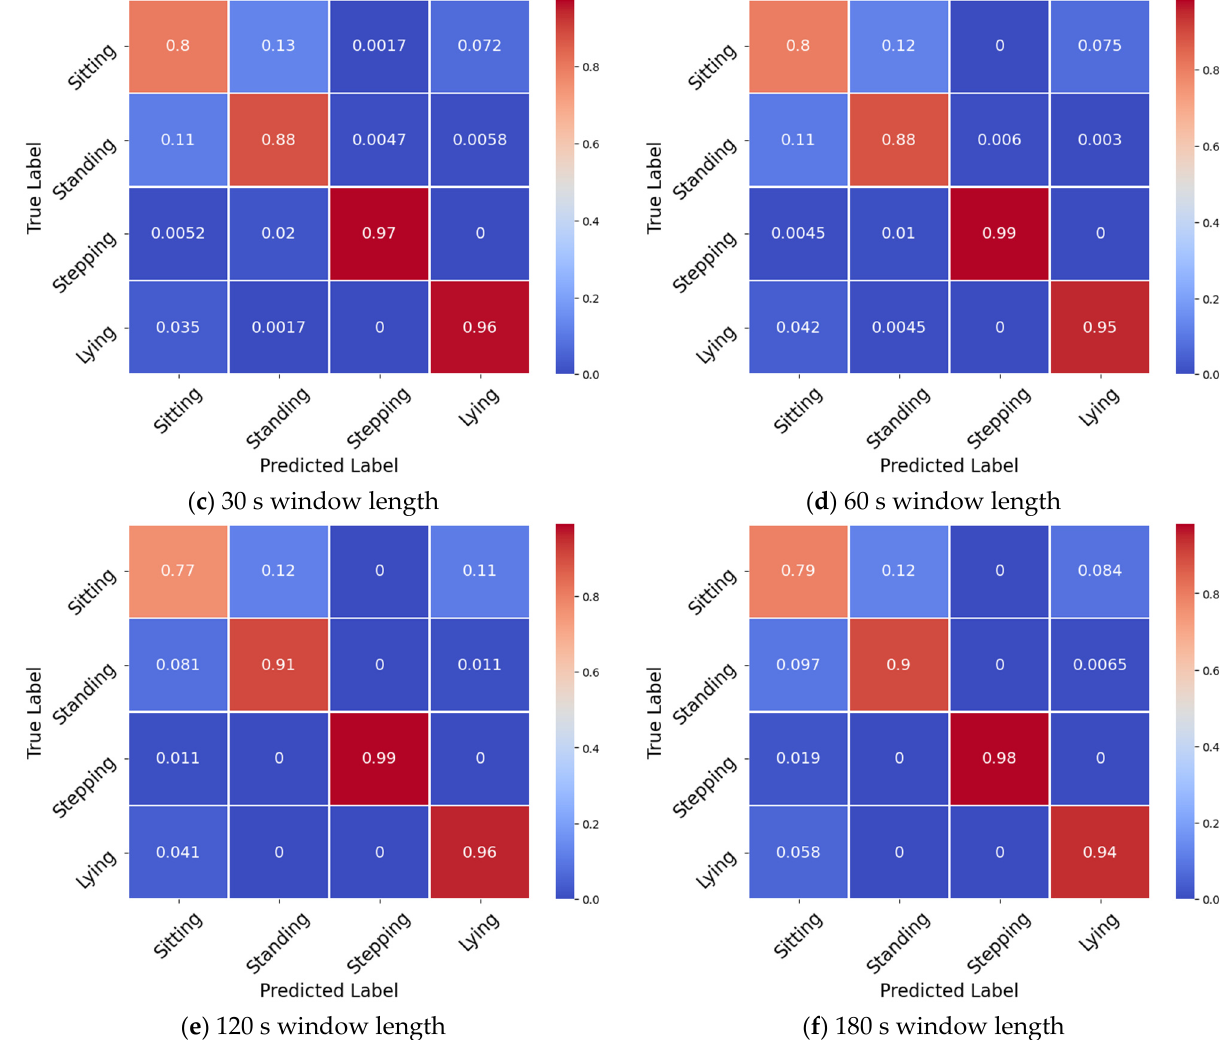
Figure 4. Confusion matrices for the RF classifier across the different window lengths: ( a ) 5, ( b ) 15, ( c ) 30, ( d ) 60, and ( e ) 120, ( f ) 180.